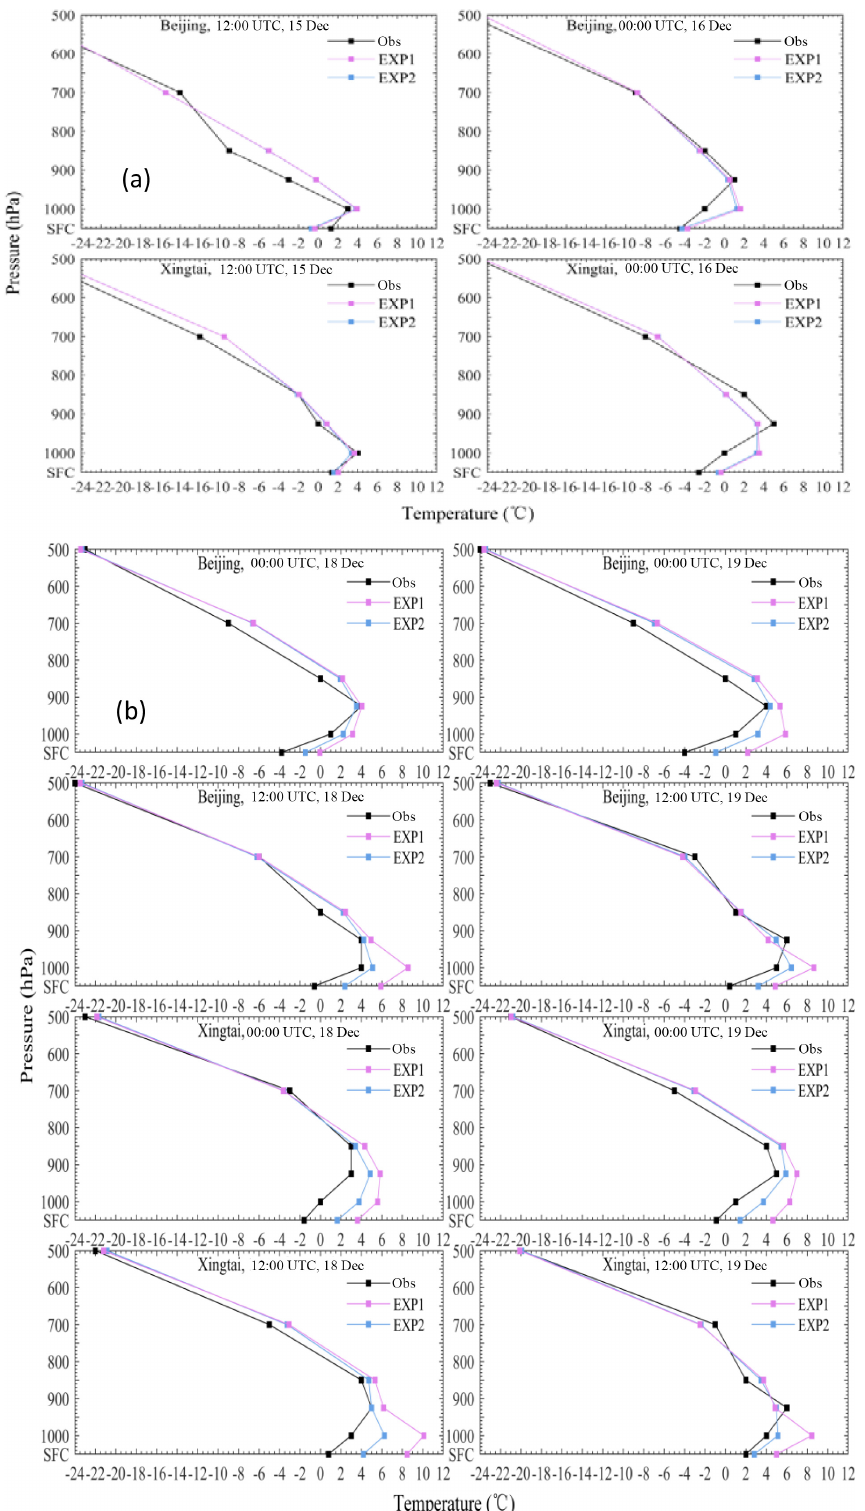
Figure 7. Sounding-observed and modelled temperature profiles in EXP1 and EXP2 during the (a) climbing stage and (b) explosive growth stage in Beijing and